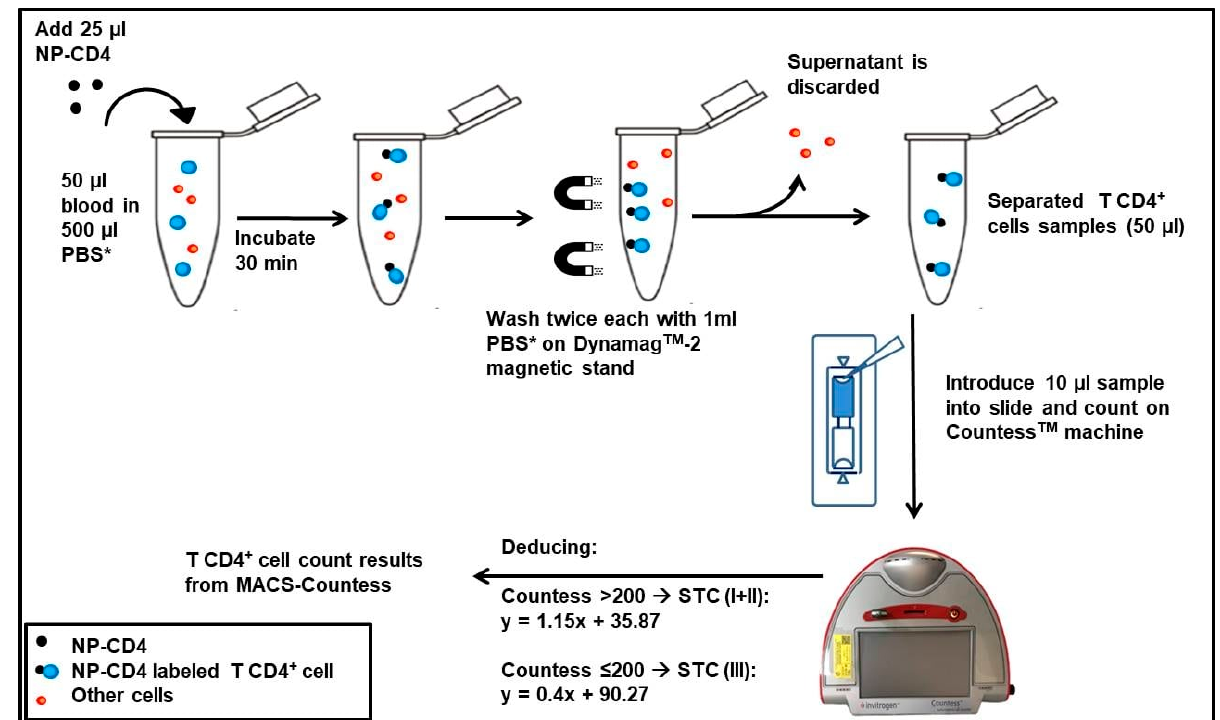
Figure 4. MACS-Countess operation and analysis scheme for CD4 + T cell counting. The 50 µ L of blood to be tested is transferred to a new 1.5 mL microcentrifuge tube together with the addition of 25 µ L NP-CD4 and 450 µ L PBS*. After 30 min of incubation at room temperature, the sample is then washed twice each with 1 mL PBS on the Dynamag TM -2 magnetic stand and is finally resuspended in 50 µ L PBS. Then, 10 µ L of the separated sample is introduced in the Countess TM slide and counted on the cell counter machine (Countess). For deducing the original CD4 + T cell count value: a Countess count of >200 cells/µL is applied to STC (I + II): y = 1.15x + 35.87, Countess count of ≤ 200 cells/µL is applied to STC (III): y = 0.4x + 90.27.